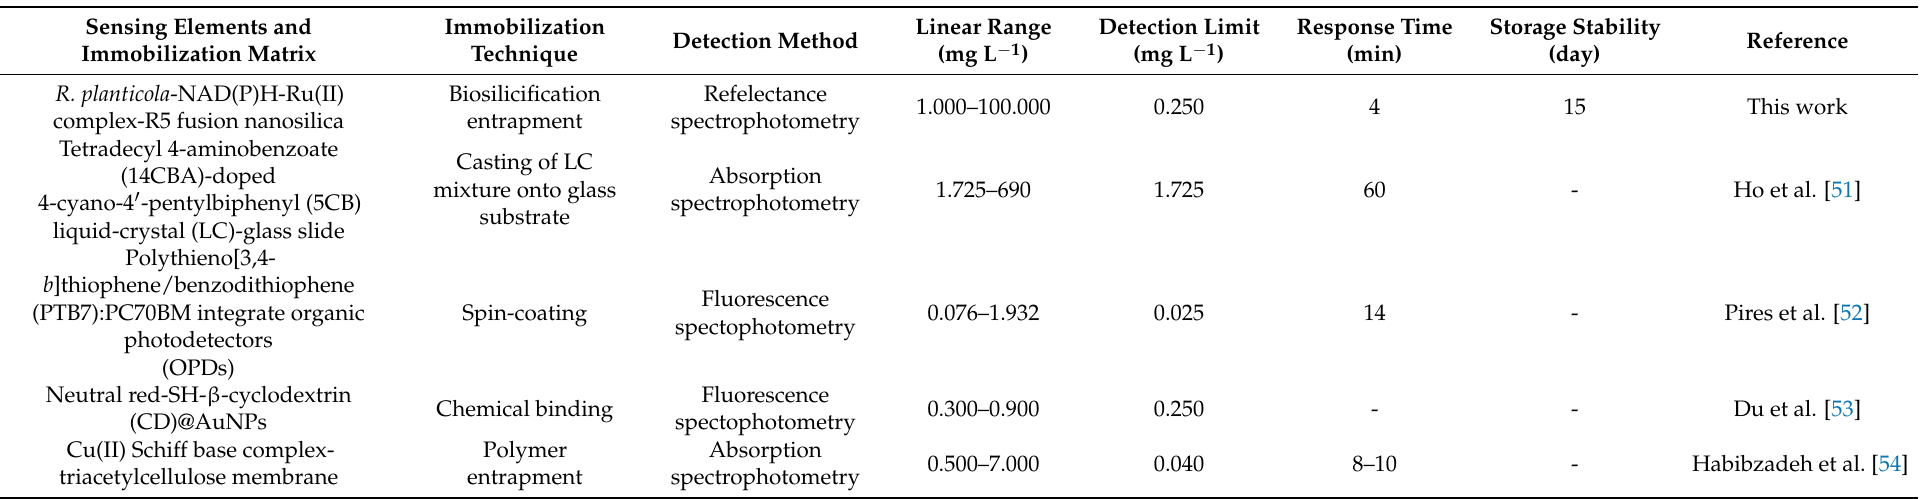
Table 3. Comparison of the developed microbial optosensor with several recently reported optical sensors and biosensors dedicated to nitrite detection with respect to linear detection range, detection limit, response time, and long-term